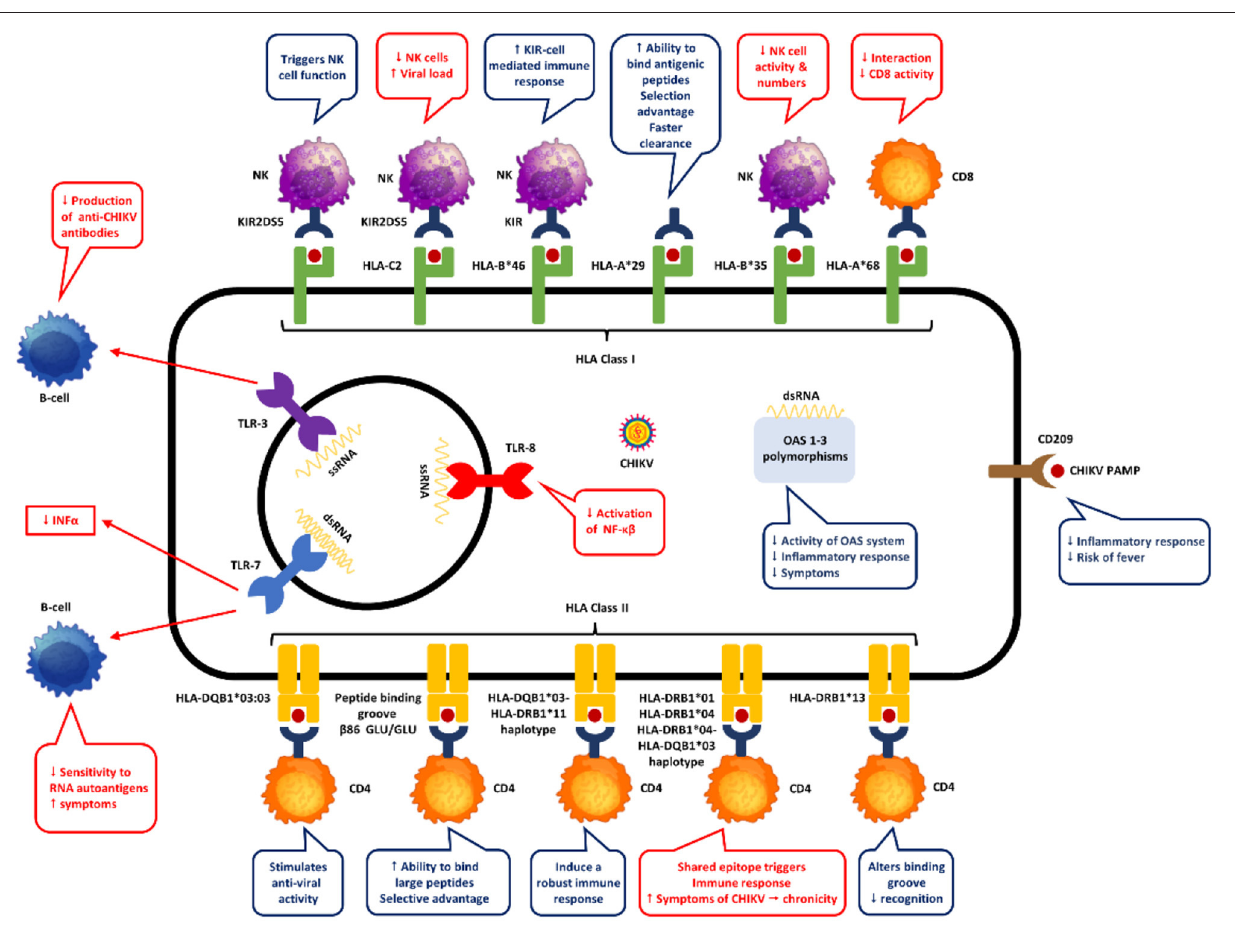
FIGURE 2 | Proposed mechanisms of genetic host factors in CHIKV